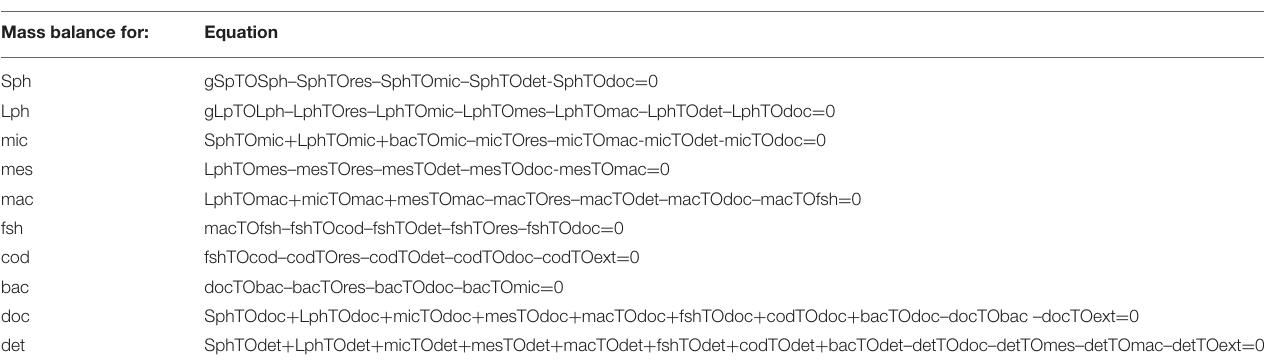
TABLE 5 | Mass balance equations (inputs–outputs = 0) for the inverse